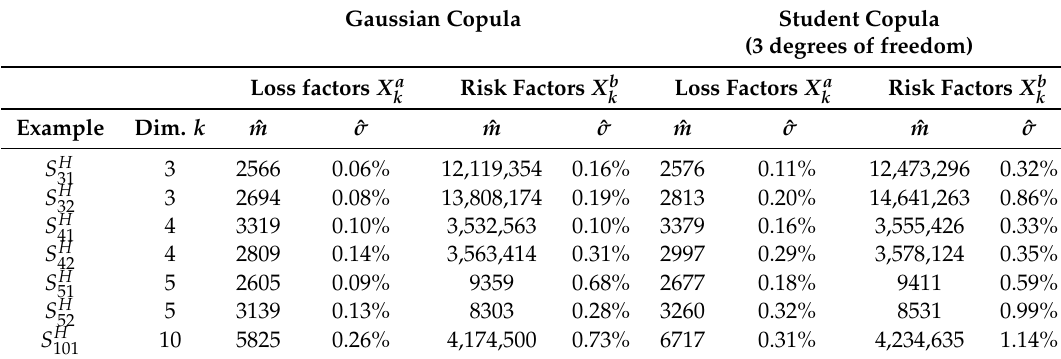
Table 8. Mean and standard deviation of the global Solvency Capital Requirement (SCR) ( Q = 2 17 simulations).